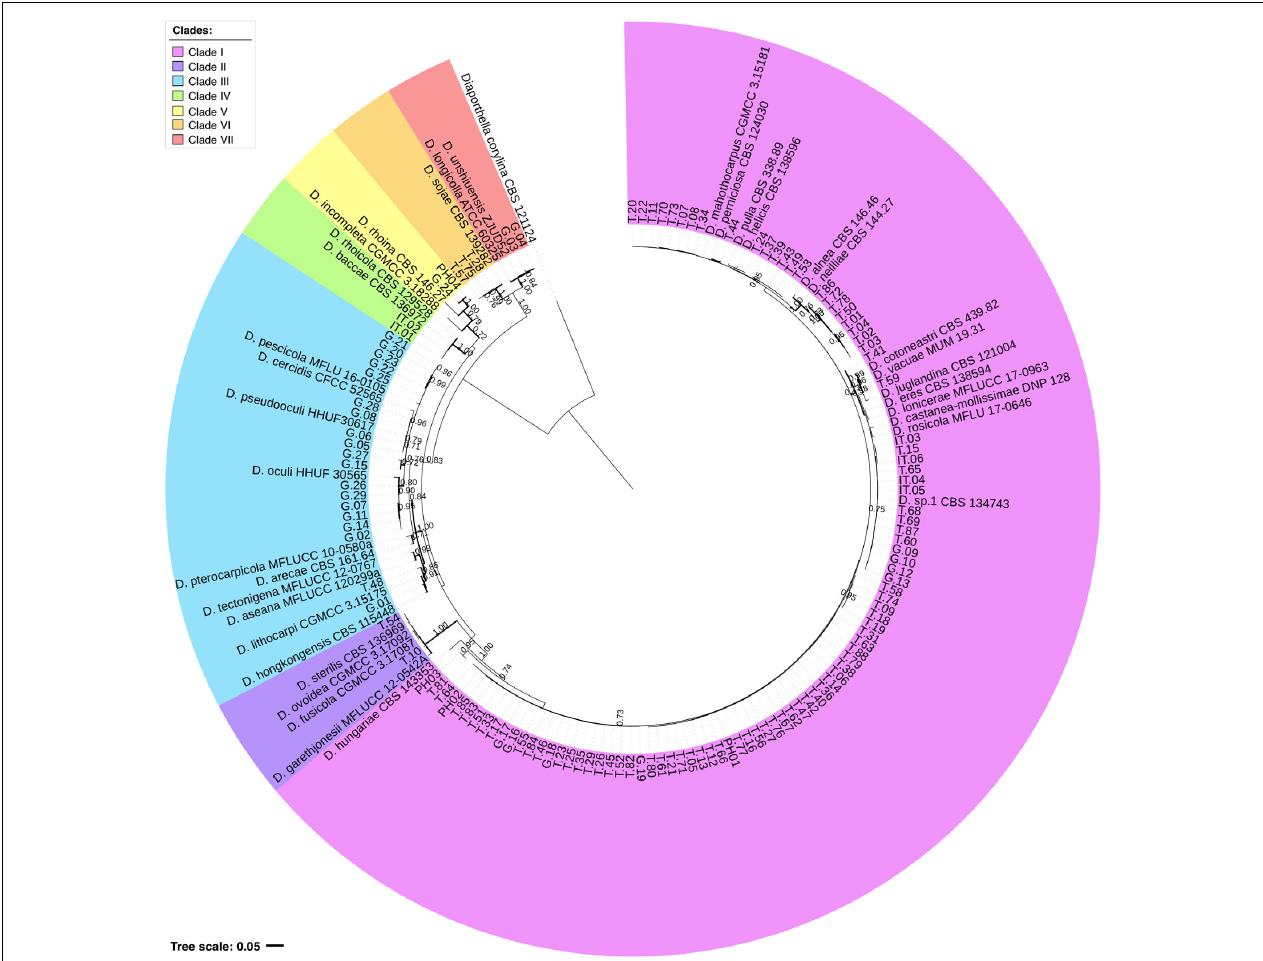
FIGURE 3 | Combined phylogeny for the ITS, EF1- α , and tub sequence data of the 125 strains isolated from hazelnuts with other Diaporthe strains detailed in Supplementary Table 1 . Diaporthella corylina CBS 121124 T was used as the outgroup. Selected model: TN93 + G + I. The percentage of trees in which the associated taxa cluster together in the bootstrap test (1,000 replicates) is shown above the branches. Bold branches are supported with ≥ 0.95 Bayesian posterior probability. The tree is drawn to scale with branch lengths measured in the number of substitutions per site. All positions with less than 95% site coverage were eliminated. The final dataset included 162 nucleotide sequences and a total of 981 positions. The tree branch topology is shown in more detail in Supplementary Figure 2 .